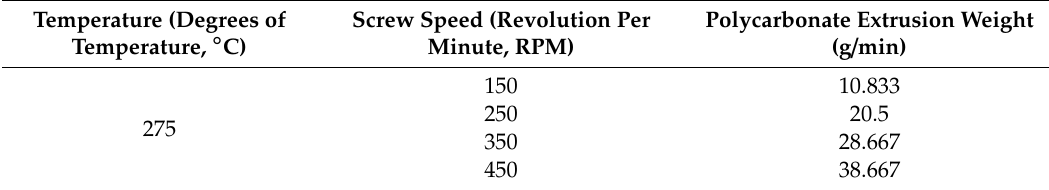
Table 5. Relationship between the relative extrusion output and the screw speed of the extruder. Temperature (Degrees